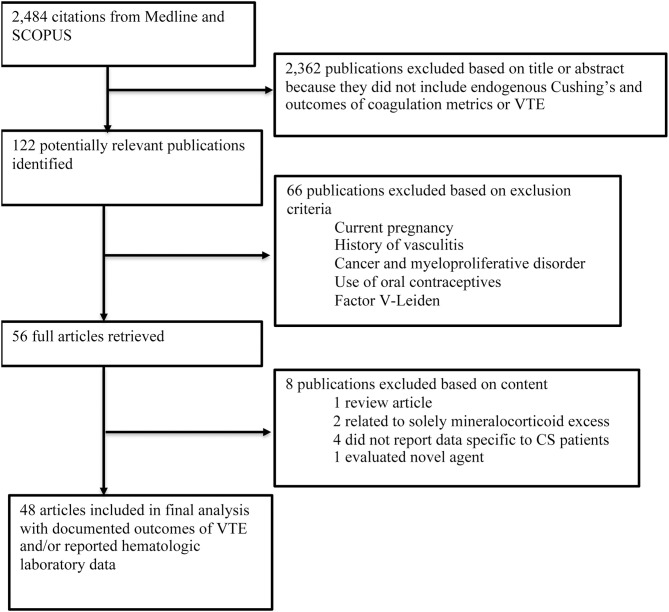
Flow chart of the search strategy and selection.